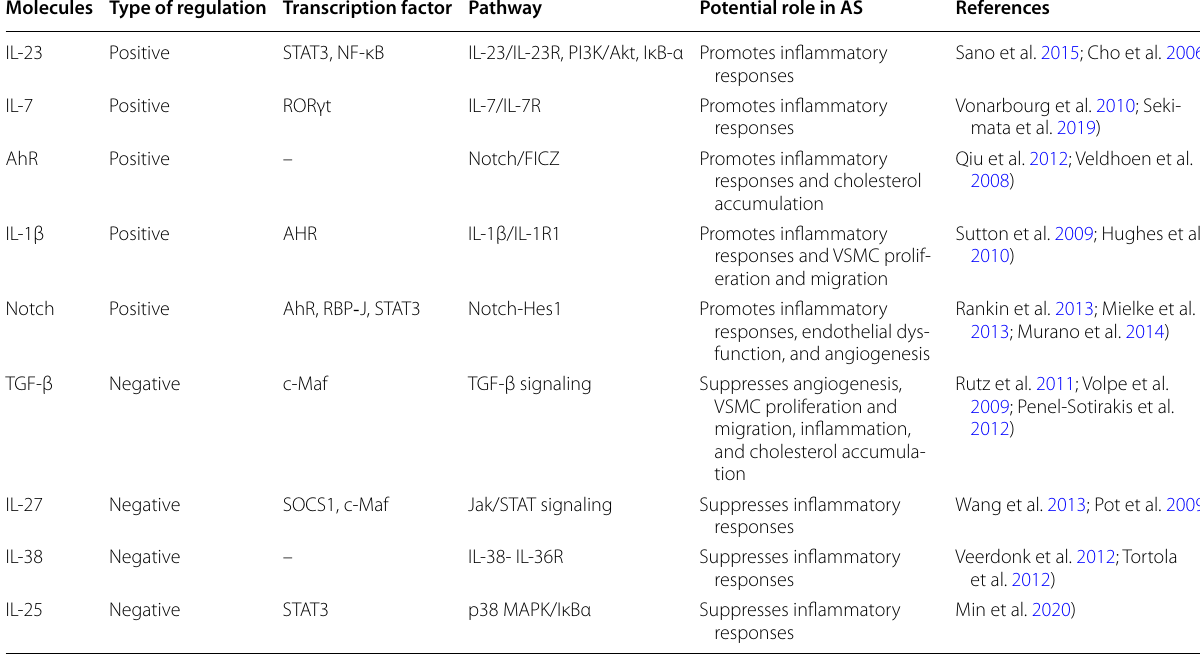
– Not determined, AS atherosclerosis